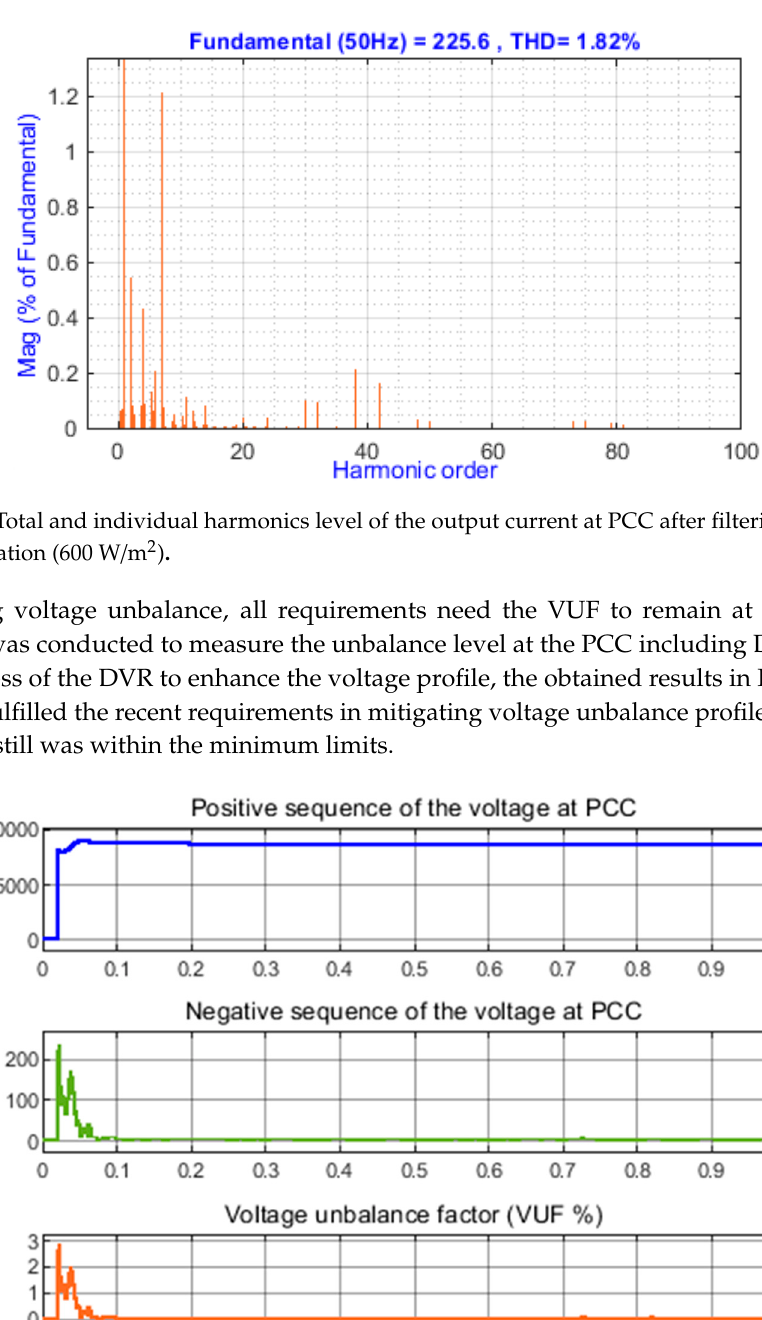
Figure 17. Total and individual harmonics level of the output voltage at PCC after filtering with low solar irradiation (600 W/m 2 ) .